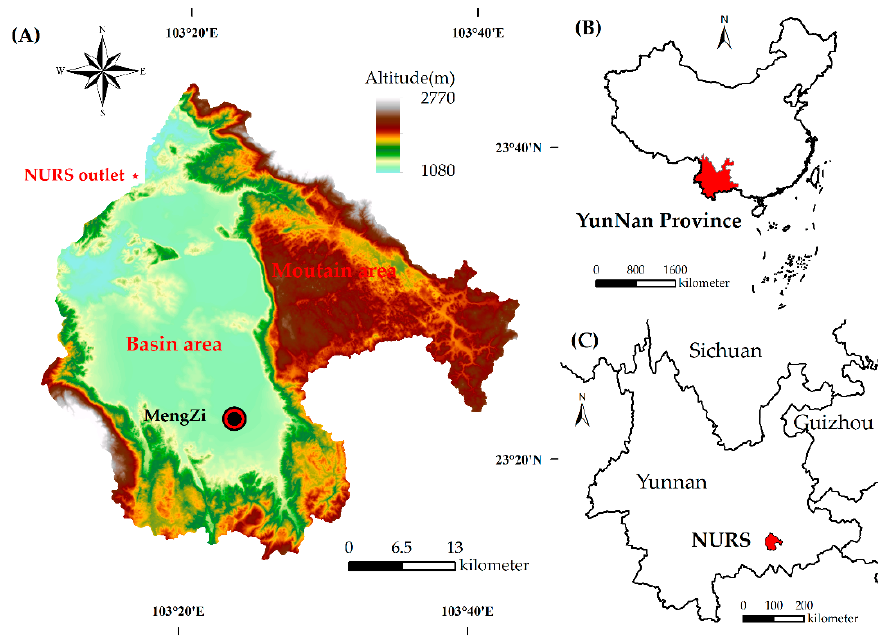
Figure 1. NURS is located in China: ( A ) Map of NURS, ( B ) Yunnan is located in China, and ( C ) NUSR is located in Yunnan.